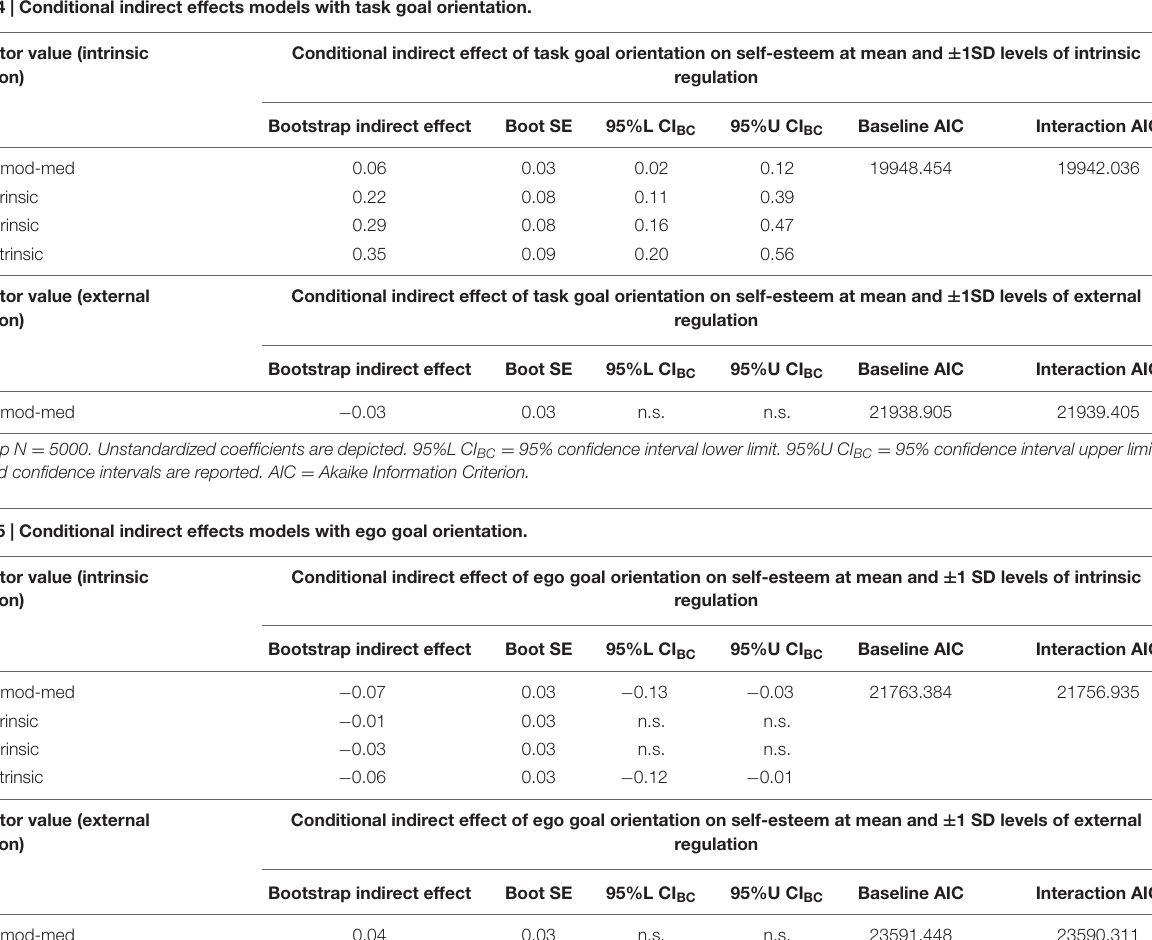
TABLE 4 | Conditional indirect effects models with task goal orientation.